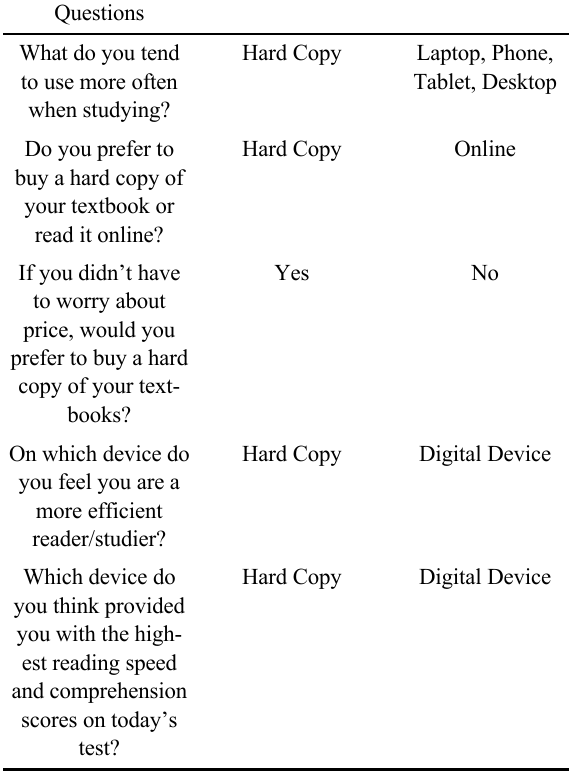
Table 1. Survey questions asked prior to the reading task.